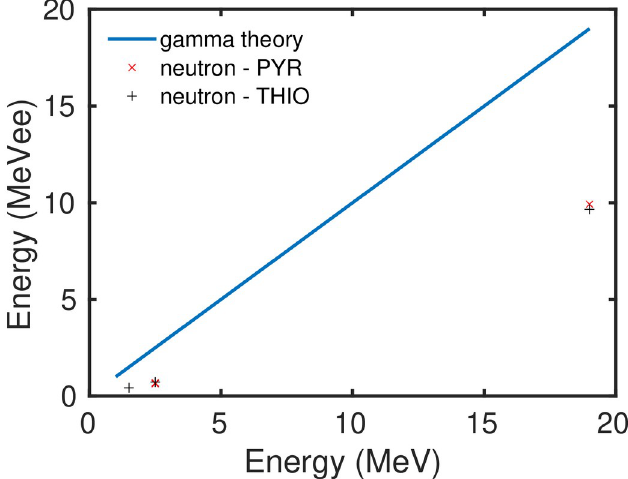
Fig 9: Summary of the light yield function relating the neutron energy to electron equivalent